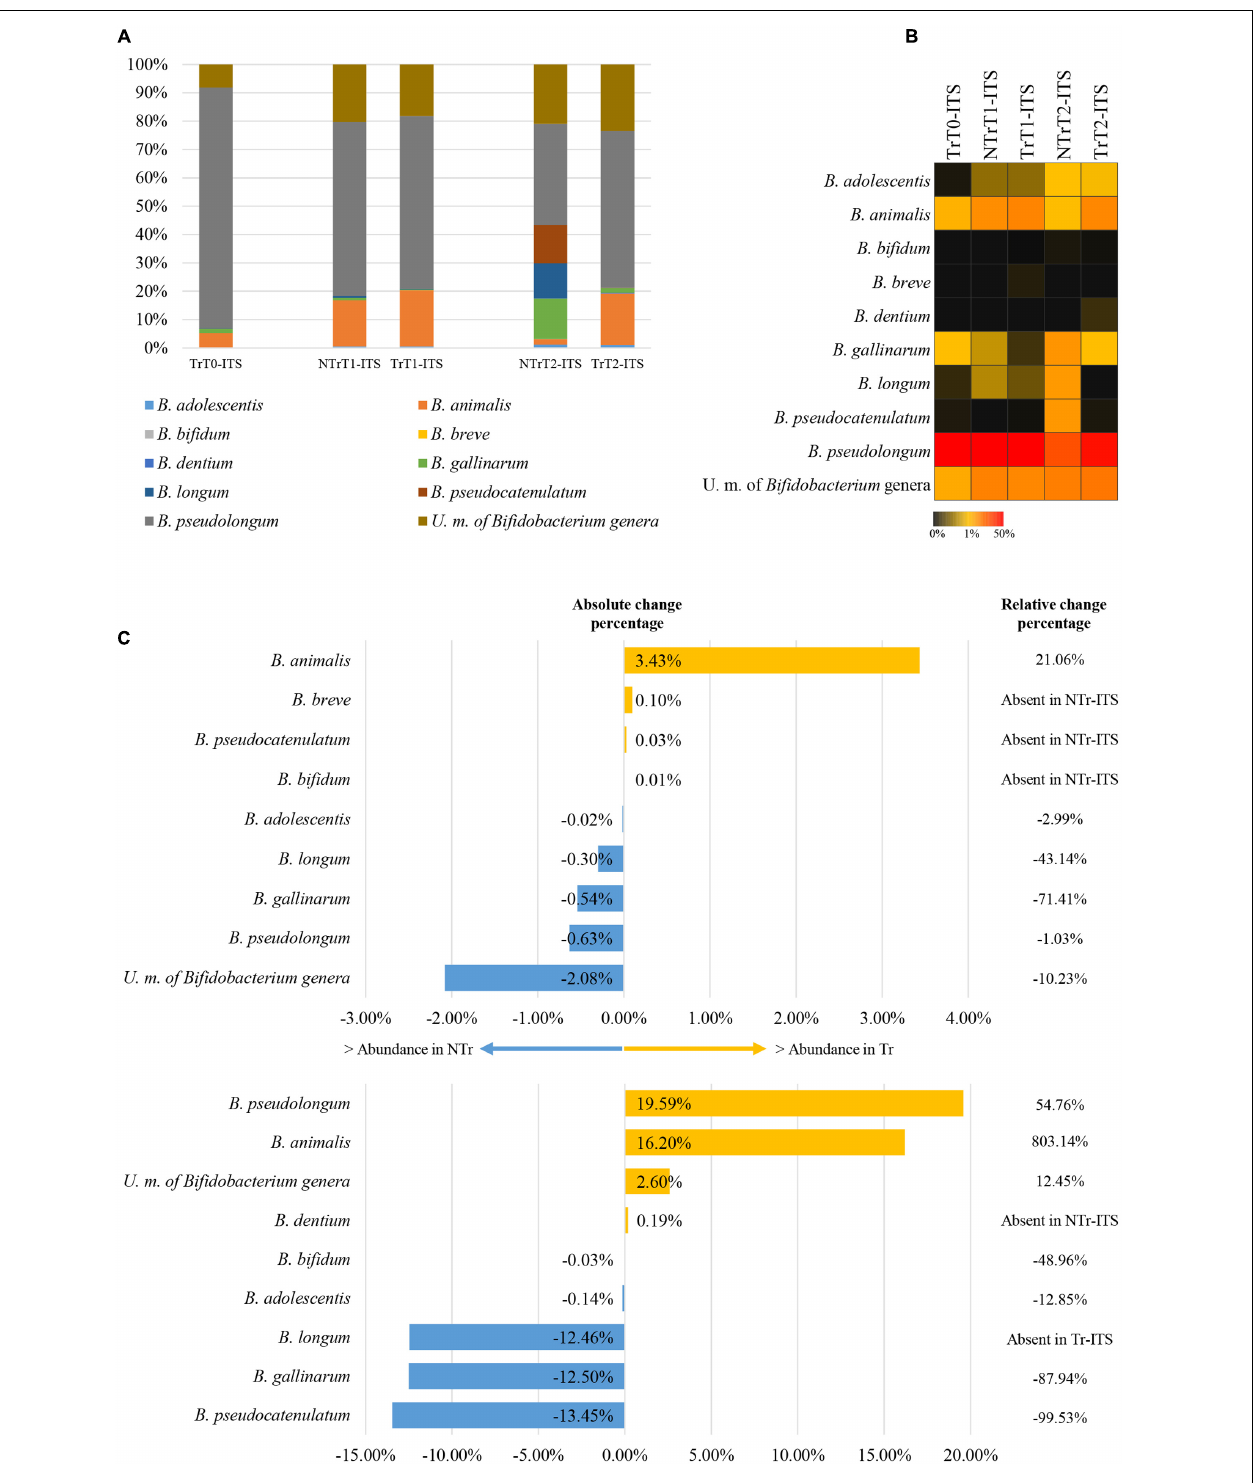
FIGURE 2 | Exploration of the bifidobacterial population of NTr and Tr groups. (A) Represents the bar plots of the identified bifidobacteria in the pooled CZ treated or untreated samples through the ITS analysis. (B) Shows heat map of the identified bifidobacteria in the pooled Tr-ITS or NTr-ITS samples. (C) Displays the variation of the bifidobacterial population at time point T1 (upward) and T2 (below). We reported the Bifidobacterium species with absolute change percentage > 0.05 % and showing increase > 100% or decrease < − 50% of relative change percentage in Tr-ITS data sets as compared to those obtained from NTr-ITS samples. In all panels the term unclassified member is abbreviated to U.